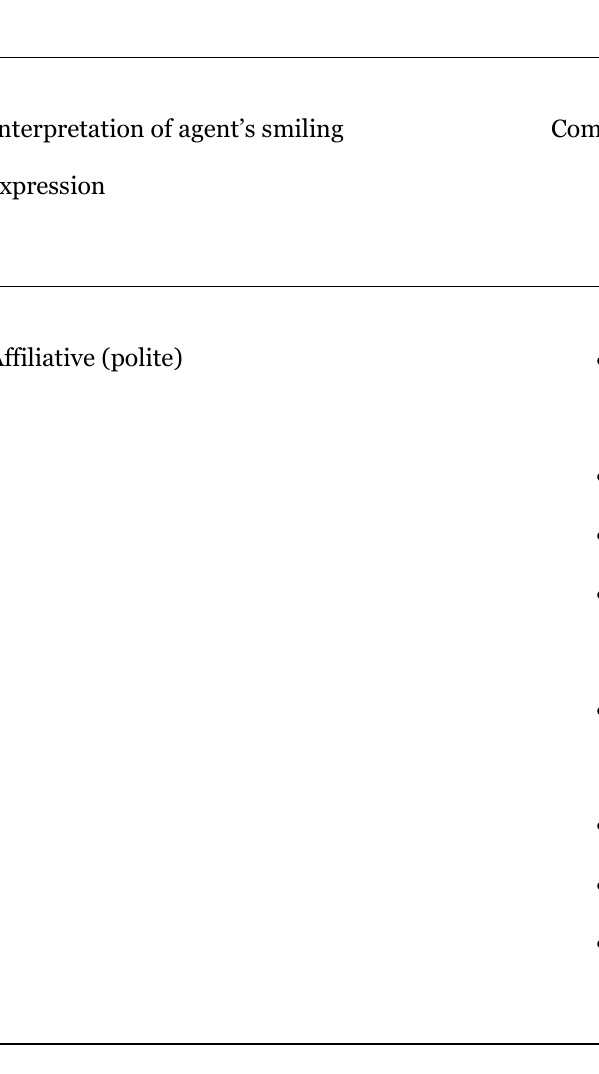
Interpretation of agent’s